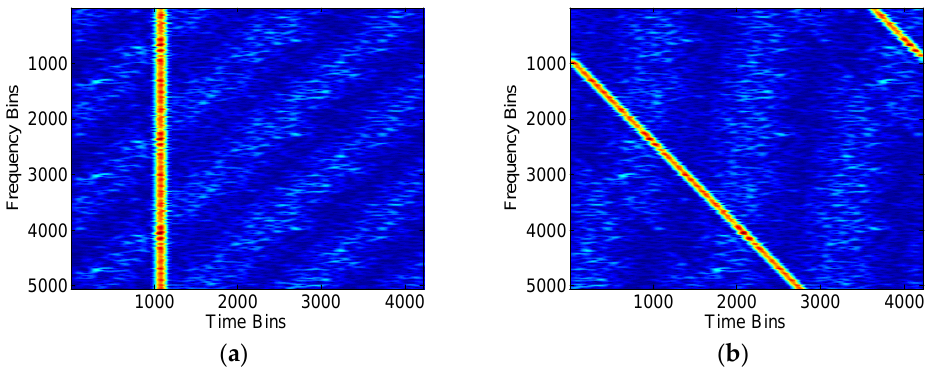
Figure 14. The representation of the measured WBI-contaminated echoes in the time–frequency domain. ( a ) The STFT of the WBI-contaminated echo before de-ramping, and ( b ) the STFT of the WBI-contaminated echo after de-ramping.